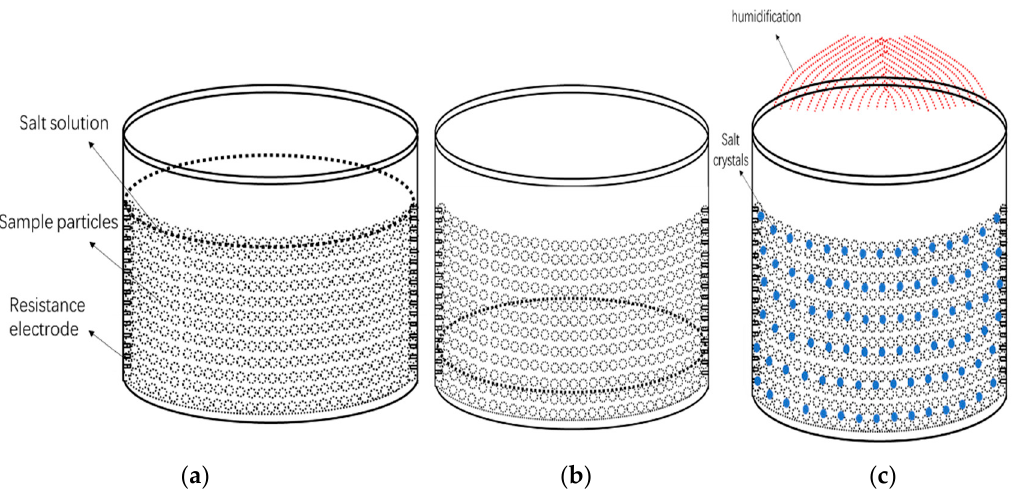
Figure 1. Schematic diagram of three types of simulation. ( a ) The salt solution in sample surface; ( b ) the salt solution cannot rise to the surface of the sample by capillary action; ( c ) simulated rainfall-drying process.